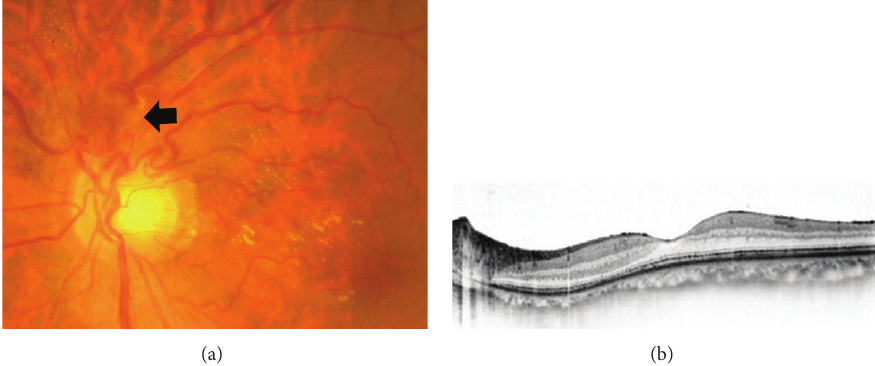
Figure 3: Fundus photograph and spectral-domain optical coherence tomographic (SD-OCT) image of the left eye at one month after intravitreal bevacizumab. (a) Fundus photograph indicates venous and arterial prepapillary loops with spiral turns and a slightly organized, yellowish-white lesion at the superior aspect of the optic disc (black arrow). Hard exudates are observed around the macula. (b) SD-OCT scan through the fovea shows no serous retinal